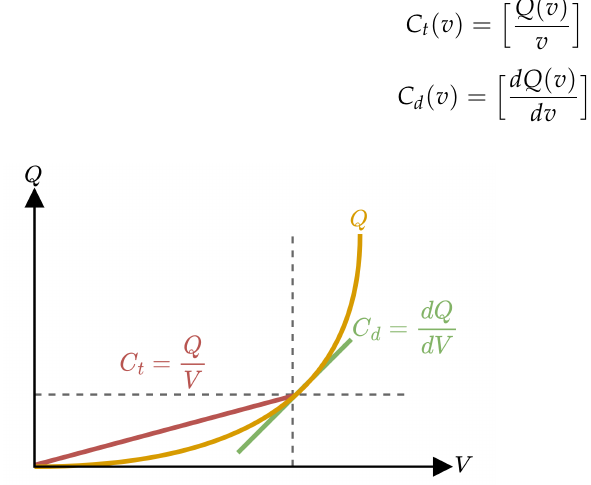
Figure 14. The concepts of total capacitance ( C t ) and local capacitance ( C d